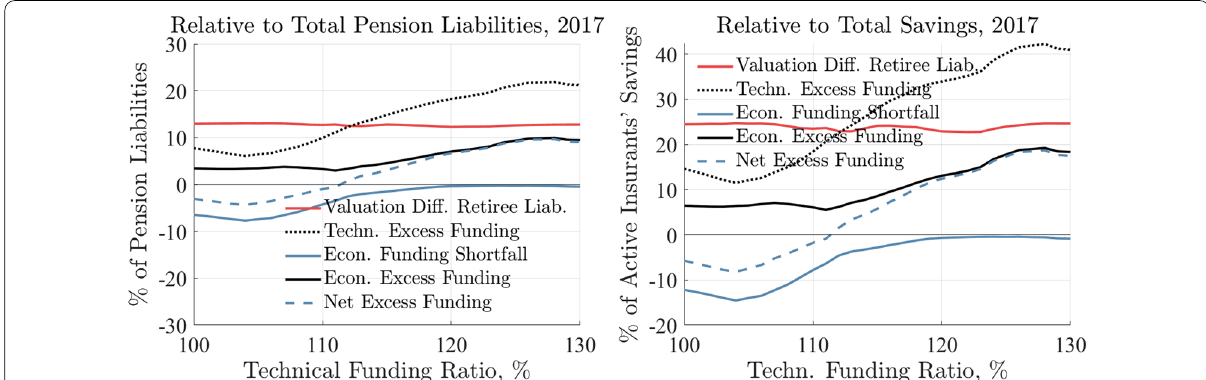
Fig. 7 Relative Valuation Difference, Excess Funding and Shortfall, 2017. Figure shows relative aggregated valuation difference and excess funding and shortfall for funds within same band width of funding ratios (x-axis) and as a share of total pension liabilities (left panel) and active insurants’ savings (right panel). The aggregation is the total sum in CHF of all funds neighboring observations within band width including closet 20% of observations and weighted by tricube kernel weights. The left panel shows shares as percent of total reported pension liabilities, the right panel as percent of active insurants’ savings. Economic funding ratios, and corresponding retiree pension liabilites evaluated at market interest rates are approximated using the conversion factors retrieved from PPCmetrics (2020). The sample includes only private and public funds without state guarantees, and only includes funds with a funding ratio between 81.5 and 152.3% (0.5th–95th percentile range of the overall